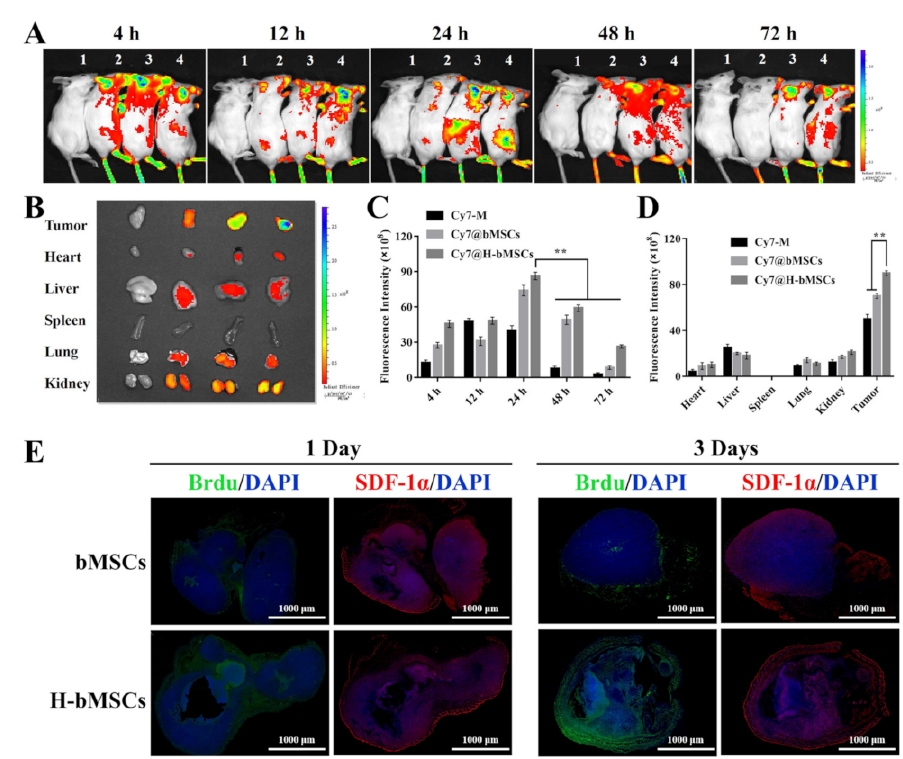
Figure 7. In vivo biodistribution of Control 1, Cy7 micelles (Cy7-M) 2, Cy7@bMSCs 3 and Cy7@H- bMSCs 4. Real-time fluorescence images of subcutaneous 4T1 cell tumor bearing mice after in- travenous injection at set time point ( A ); the fluorescence images of ex vivo tissues at 24 h post- injection ( B ); the quantitative analysis of the fluorescence intensity in mice and in tissues are shown in ( C , D ), respectively. The distribution of H-bMSCs and bMSCs at tumor sites (green fluorescence) at one day and three days after intravenous injection, the SDF-1 α were labeled with red fluorescence ( E ). (** p <